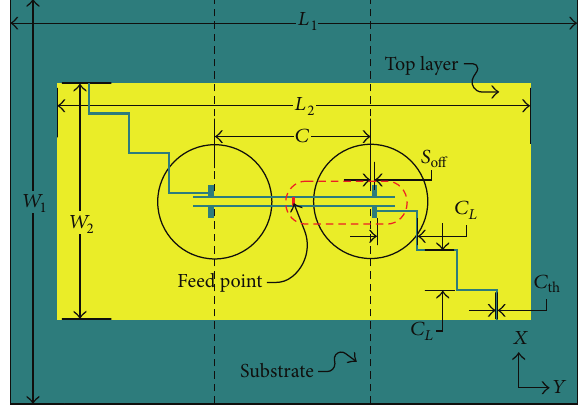
Figure 3: Top view of proposed antenna geometry ( XY plane), with = 14 mm, 𝑊 𝐿 1 0 mm, 𝐶 𝐿 = 1mm, and 𝐶